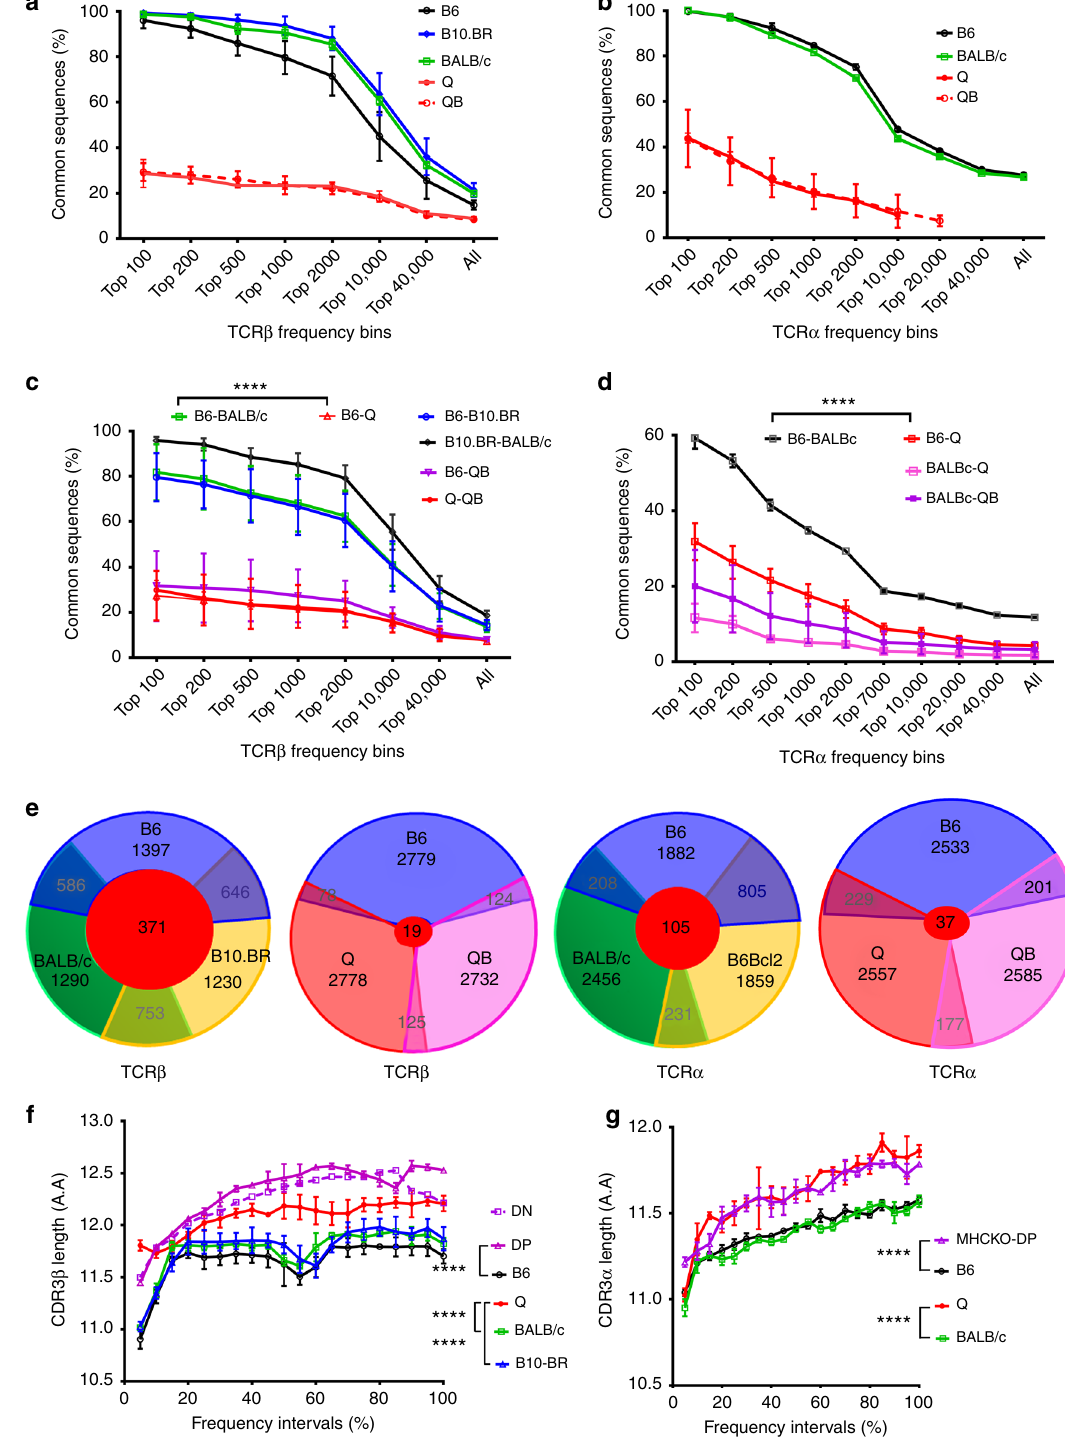
Fig. 1 Overall αβ TCR sequence overlap comparisons among various MHCr and MHCi repertoires. a , b Percentage of TCR β ( a ) and TCR α ( b ) sequence overlaps observed within each strain of B6, B10.BR, BALB/c, Quad ko (Q), or Quad ko Bcl-2 tg (QB) animals. c , d Percentage of TCR β ( c ) and TCR α ( d ) sequence overlaps observed between different strains of animals. The pair-wise sequence overlapping percentages are calculated using top 100, 200, 500, 1000, 2000, 10,000, 40,000 highest frequency and all sequences of each strain, respectively. e TCR β and TCR α common sequences overlapping among the top 3000 sequences from B6, B10.BR, BALB/c, Quad ko (Q), or Quad ko Bcl-2 tg (QB). f , g The distribution of average length of CDR3 β ( f ) and CDR3 α ( g ) in MHCr and MHCi TCR repertoires with respect to their frequency intervals. Sequences from each strain were grouped by 5% intervals from the top 5% frequent sequences until the accumulation of all sequences (100%). The error bars indicate standard deviations from the means. The p-values all fi